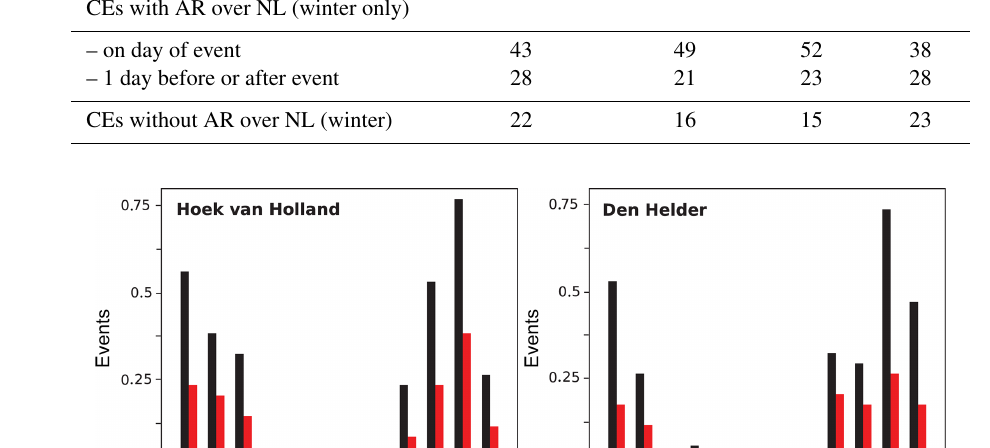
Table 1. Number of compound events associated with AR landfall relative to the total number of compound events at the four coastal stations under investigation during the ERA-Interim period (1979–2015). For an explanation of terminologies and a definition of the different types of compound events please refer to the text.